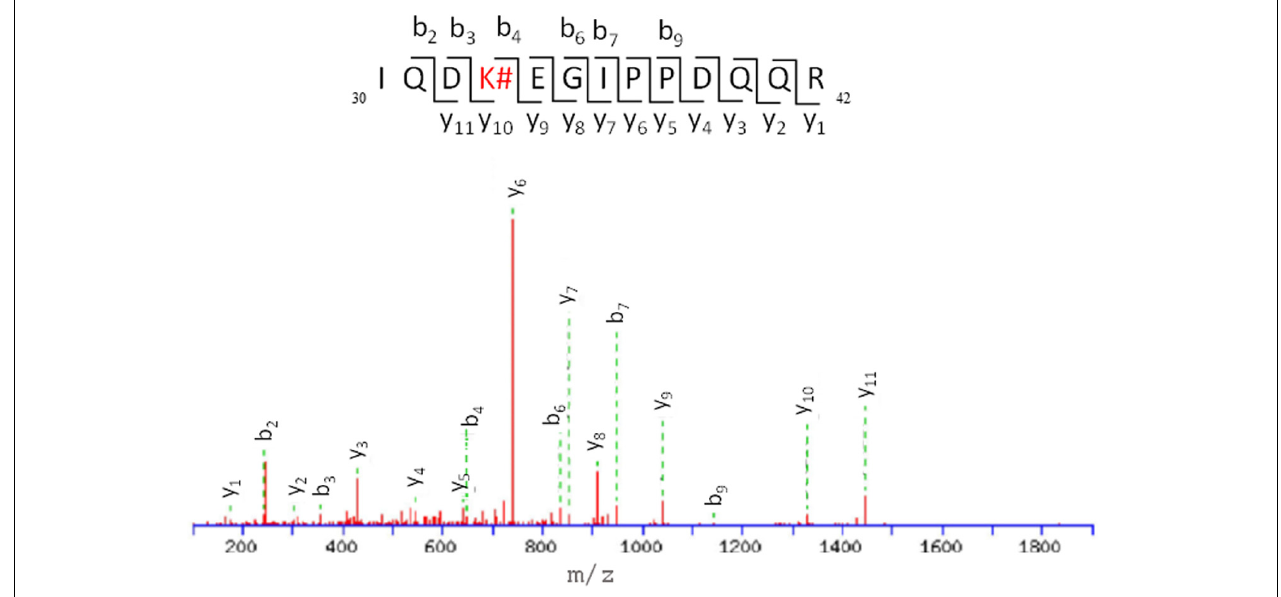
FIGURE 7 | ESI-MS/MS spectra and fragmentation pathway of the HTB-modified peptide